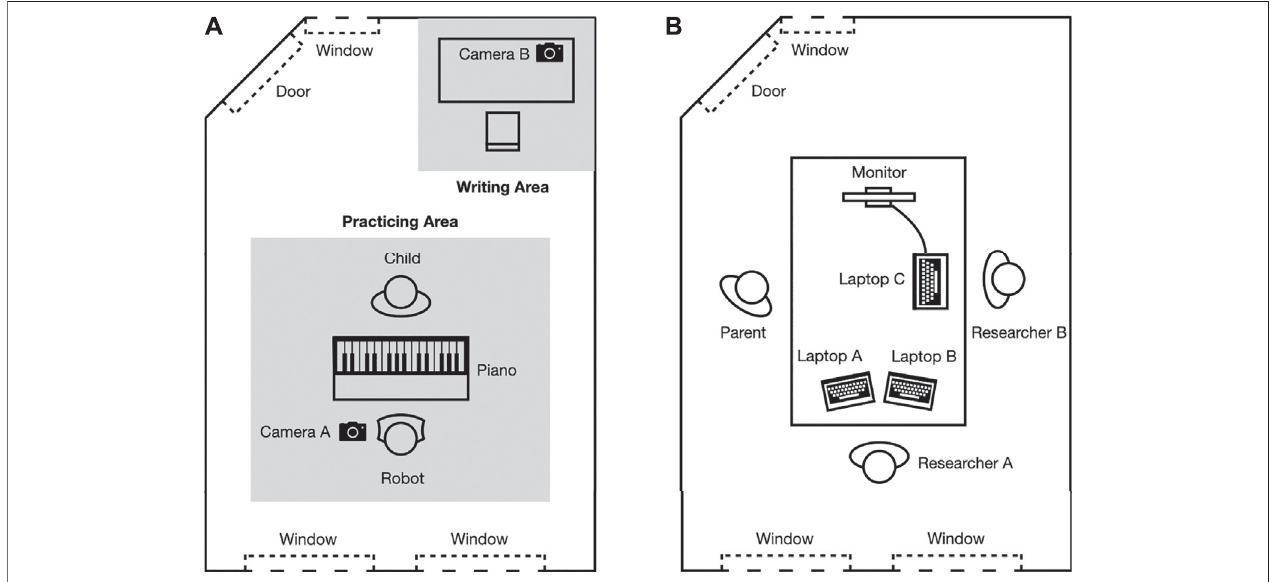
FIGURE 2 | Top view illustration of the experiment room (A) and the control room (B) .